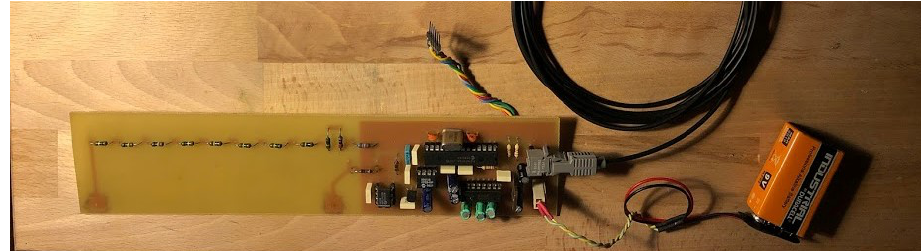
Figure 15. The high voltage measuring board PCB.